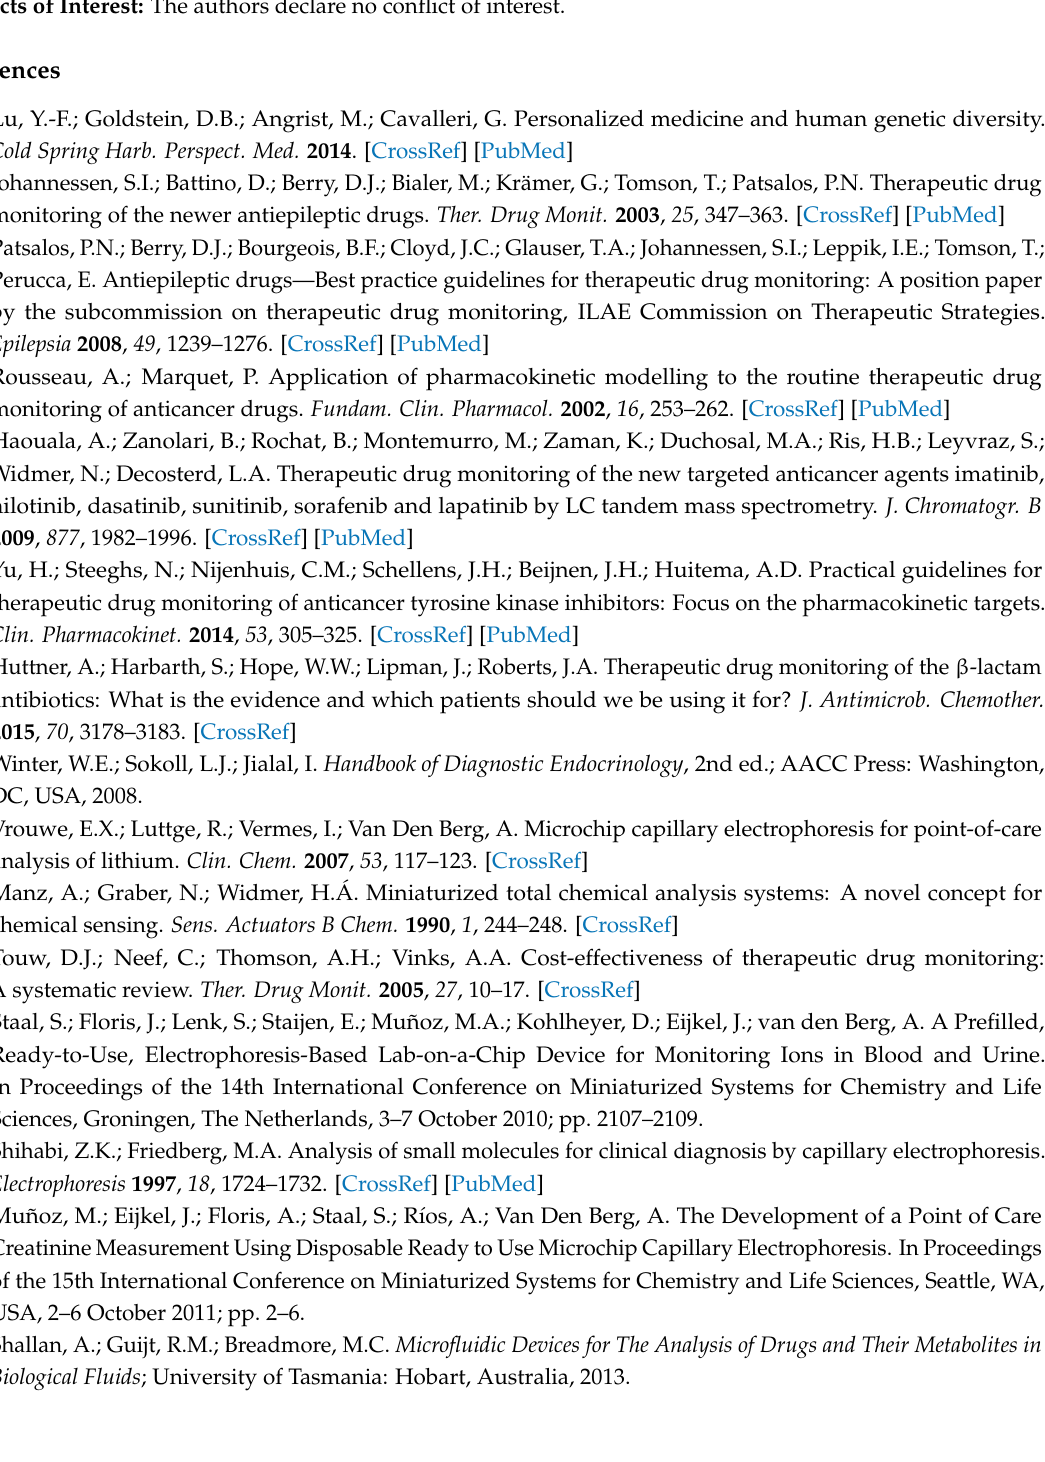
Figure S1: Schematic of the PMMA fabrication process. Figure S2: Analysis of Aminoglycosides from whole